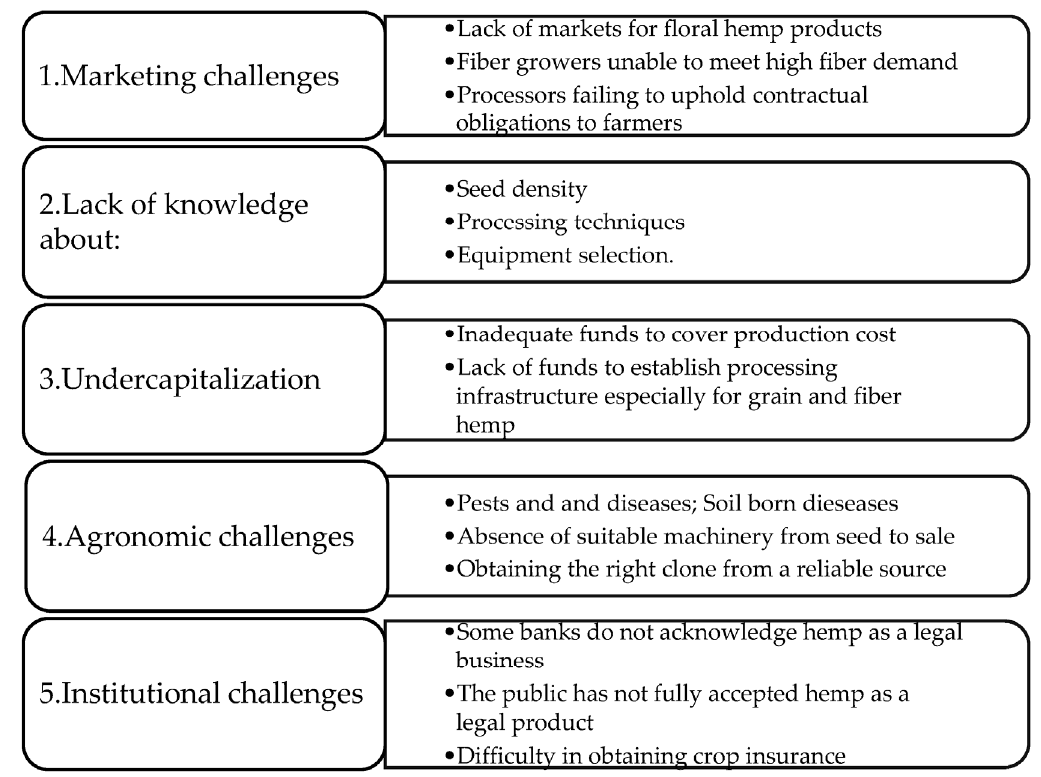
Figure 8. Potential challenges facing the hemp industry in NC .